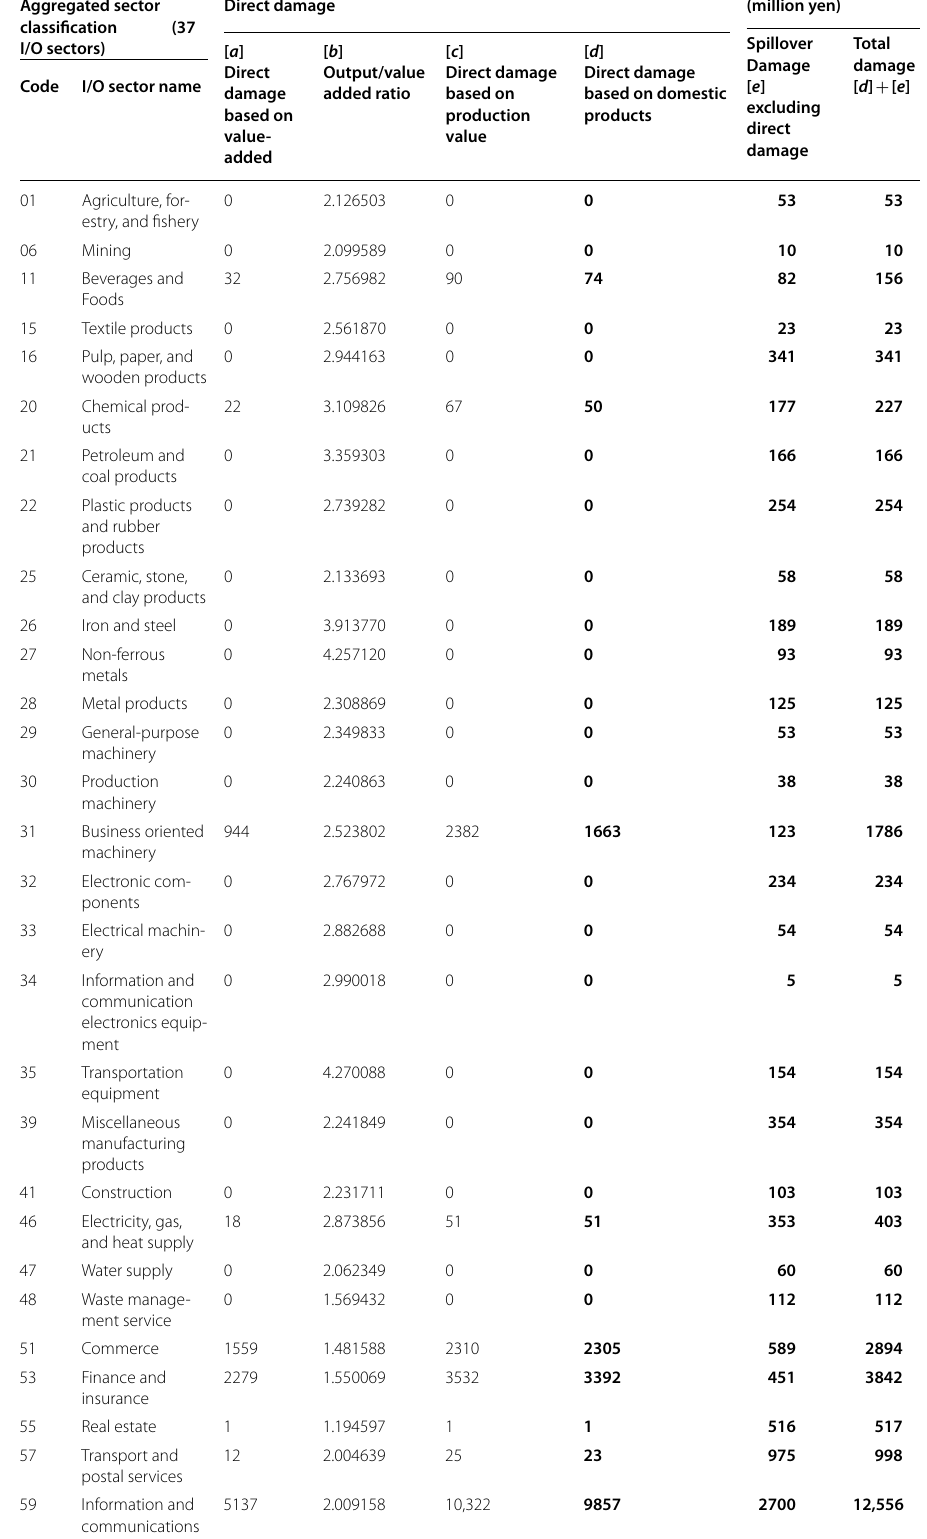
Table 3 Direct, spillover, and total damages in 37 I/O industrial sectors (Japan) Aggregated sector